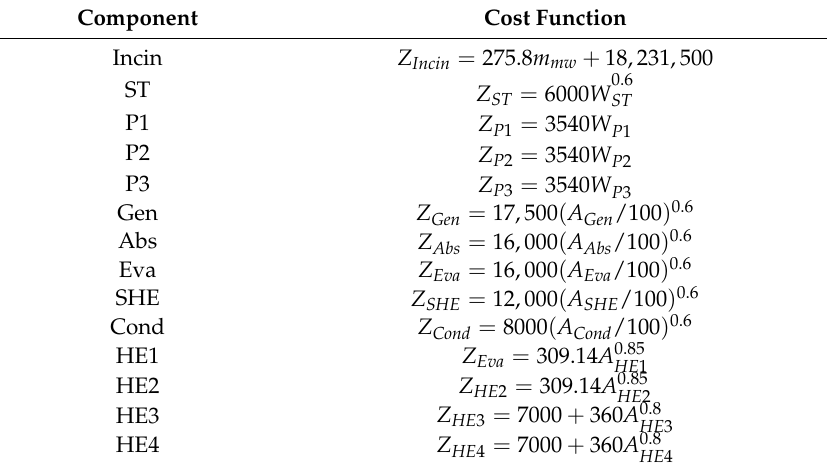
Table 2. Cost functions of the proposed CCHP components